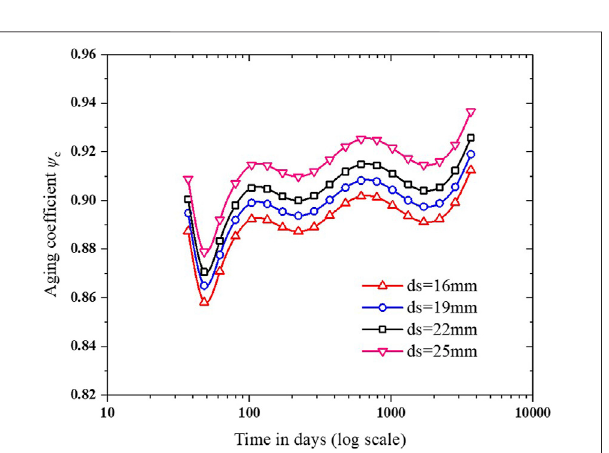
FIGURE 6 | Aging coef fi cient with increasing stud